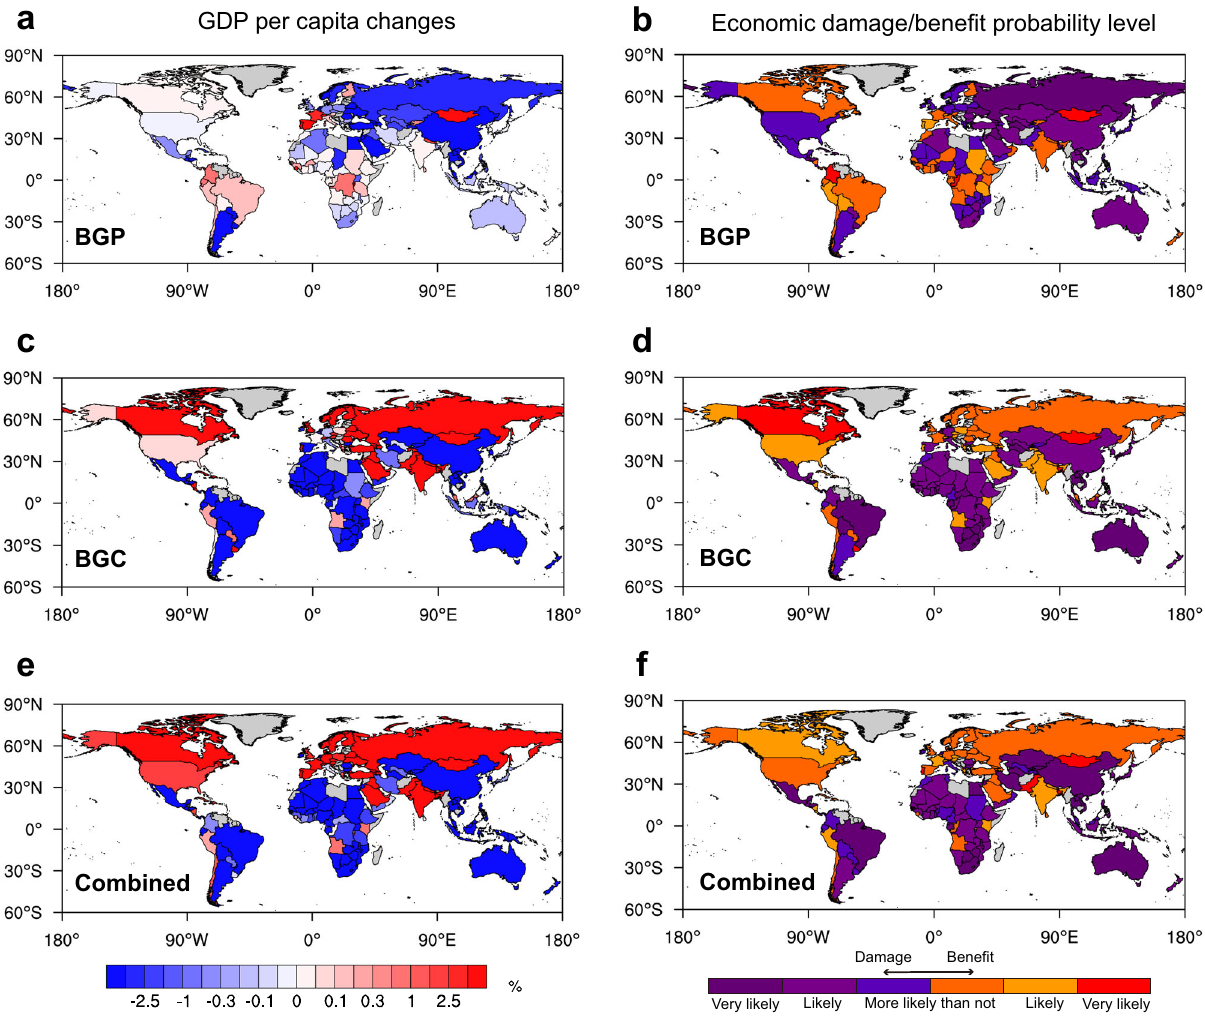
Fig. 8 Country-level cumulative economic impacts via annual-mean day-to-day surface air temperature (SAT) variability changes from 1993 to 2012 due to biogeophysical (BGP) and biogeochemical (BGC) impacts of historical land-use and land-cover change (LULCC). The ensemble median of the relative changes in GDP per capita (%) in 2012 induced by ( a ) BGP, ( c ) BGC, and ( e ) their combined impacts. The corresponding probability level of the economic damage/bene fi t according to the IPCC uncertainty guidance 66 for ( b ) BGP, ( d ) BGC, and ( f ) their combined impacts. “ Very likely ” , “ Likely ” , and “ More likely than not ” indicate that more than 90%, two-thirds, and half of the members agree on the response, respectively. Countries and regions with missing values are shaded in